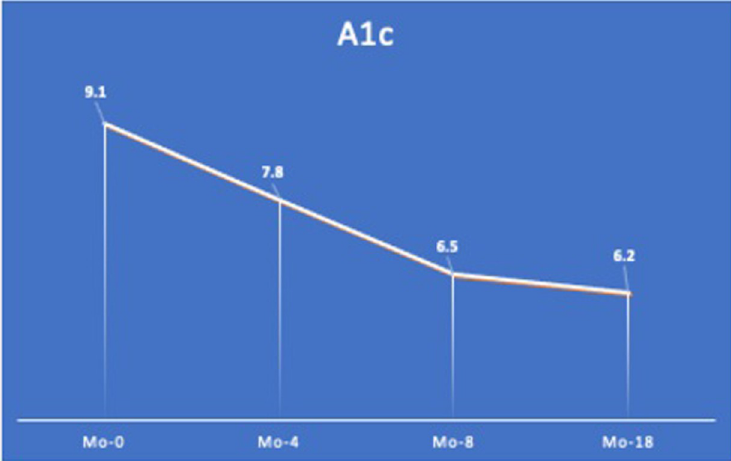
Fig 7. Change in A1c value. The level of A1c was reduced from 9.1 to 6.2 in 18 months (Mo) after re-establishing dental occlusion by an implant-supported fixed